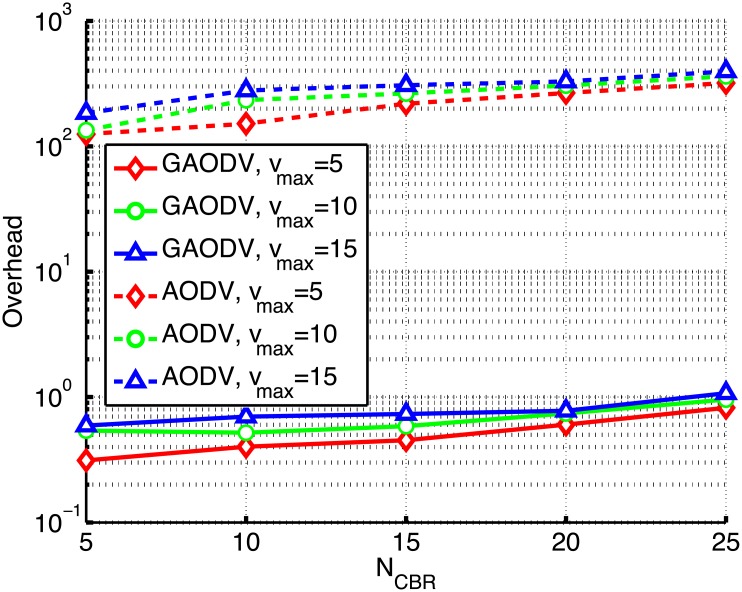
Routing overhead for the change of NCBR and vmax.